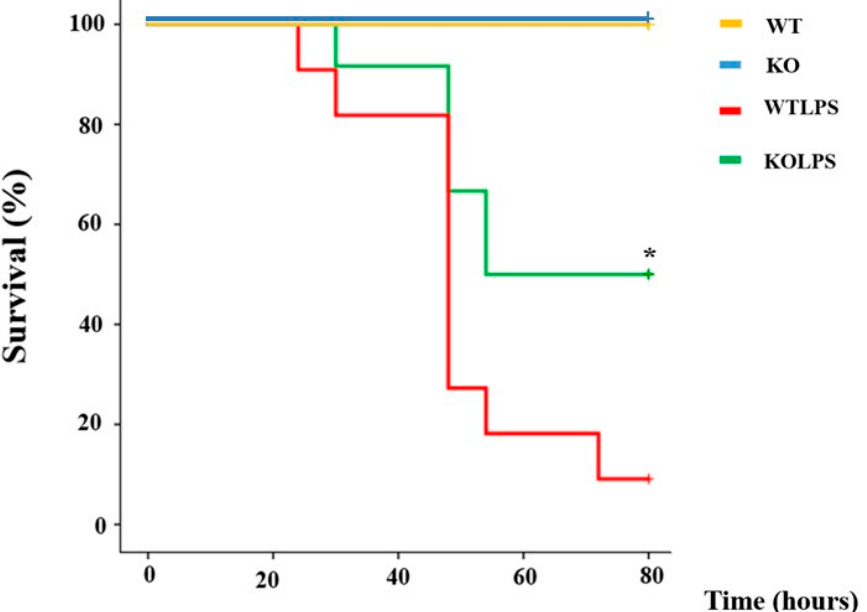
Figure 1. Gal3 knockout mice are more resistant to septic shock. WT and Gal3KO mice were sub- jected to an intraperitoneal injection of LPS (5 mg/kg of body weight) or saline solution ( N = 12 animals per group). The mortality rate was monitored regularly for 80 h and represented as per- centage of survival. The statistical analysis was performed using the Log-Rank Test. Abbreviations: WT, wild type mice; KO, Gal3 knockout mice; WTLPS, wild type mice treated with LPS; KOLPS, Gal3 knockout mice treated with LPS. *, p <